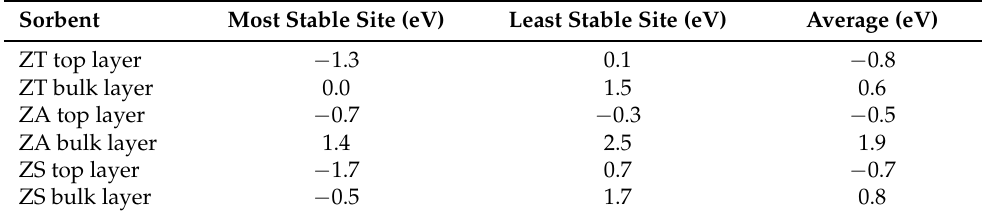
Table 3. The ∆ G of the most stable, least stable and their average for the investigated sorbents.